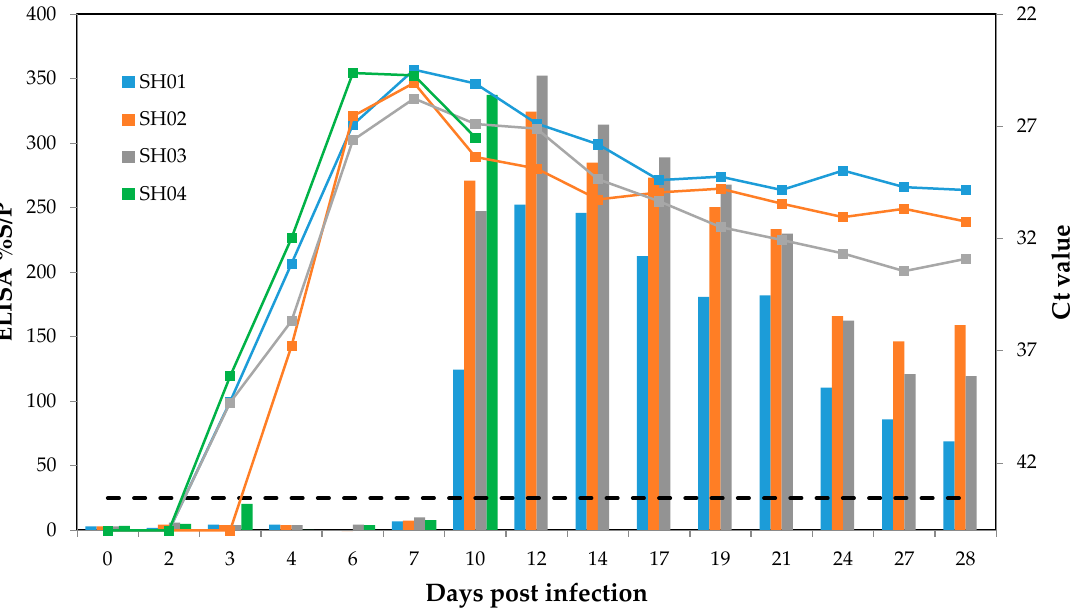
Figure 1. BTV RNA and antibody levels in BTV-14 infected sheep. Real-time RT-PCR Ct values are shown as coloured lines and seroconversion determined using ELISA shown as bars. The dashed line indicates the negative cut-off value of the ELISA.